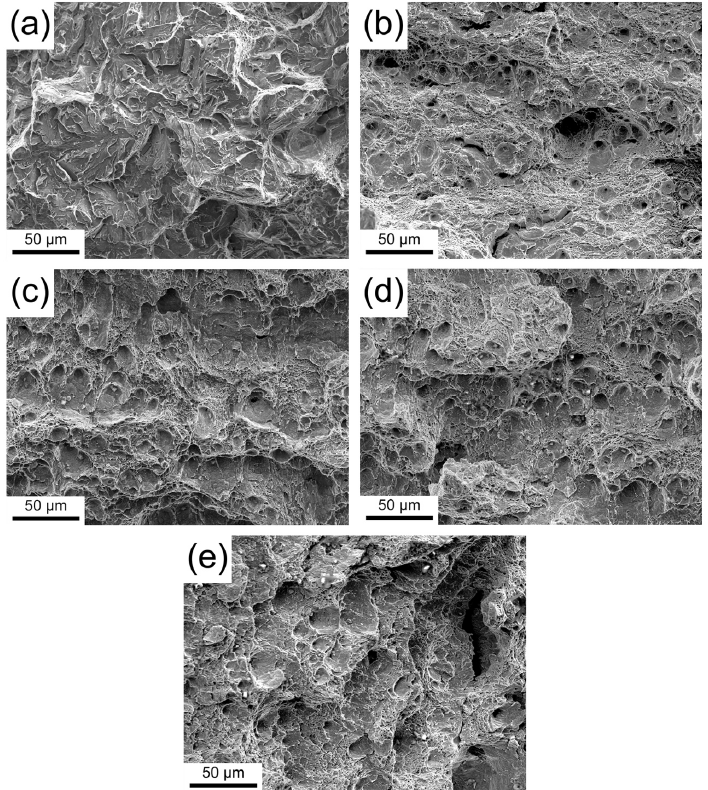
Figure 6. SEM micrographs of the impact fracture surfaces of the T92 heat-resistant steel samples tempered at different temperatures: ( a ) 715 °C, ( b ) 740 °C, ( c ) 765 °C, ( d ) 790 °C, and ( e ) 815 °C.